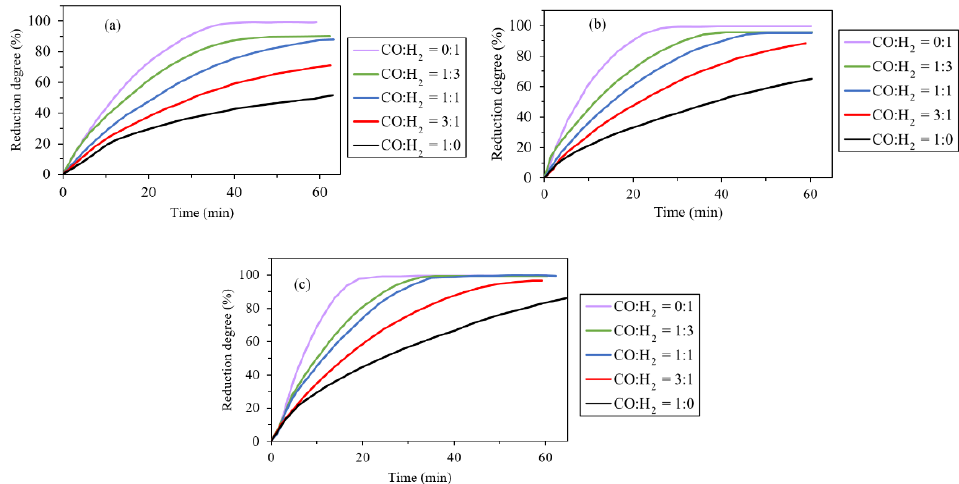
◦ C; ( b ) 900 ◦ C; ( c ) 1000 ◦ C [32] “modified”.